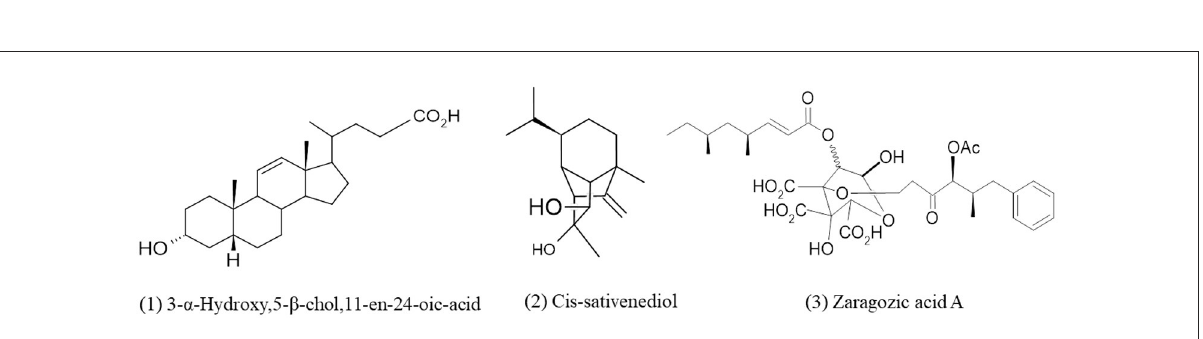
FIGURE2 Chemical structures of bioactive compounds of terpenes family of Curvularia spp. (1) 3- α -Hydroxy,5- β -chol,11-en-24-oic-acid, (2) Cis-sativenediol, and (3) Zaragozic acid